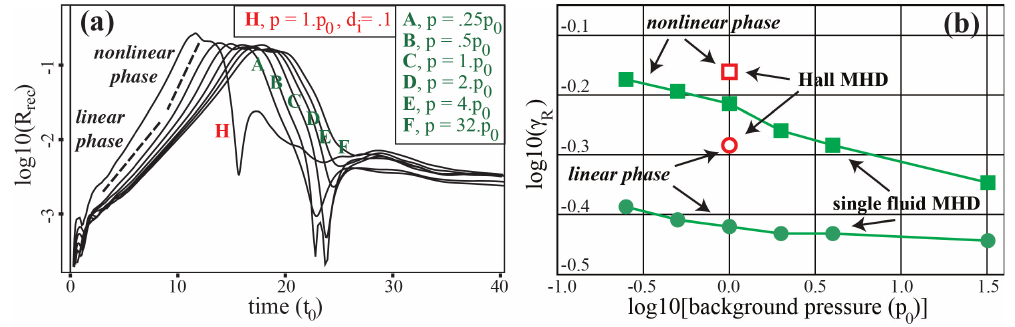
Fig. 8. (a) Time traces of normalized reconnection rate R rec for the six single-fluid MHD simulations with varying plasma β (labeled A – F ) and the Hall MHD simulation (labeled H ) described in Fig. 3. (b) The effective growth rate γ R of R rec versus the background pressure in the early linear and late nonlinear phases of reconnection.